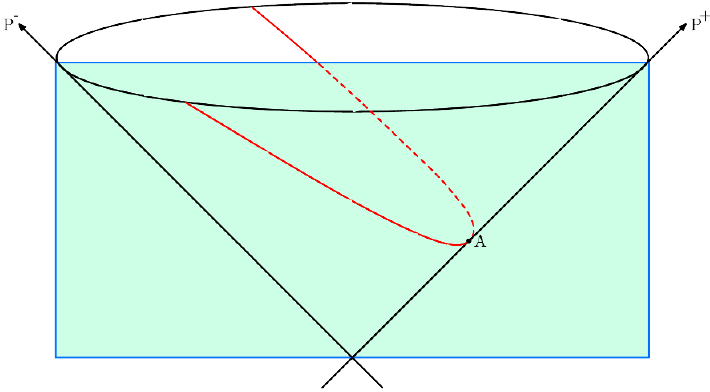
Figure 1 . The intersection of a defect hyperplane (containing the P + -direction) with the Poincar(cid:19)e section (denoted here by point A) of the null-cone in embedding space leads to (cid:13)at defect in the physical